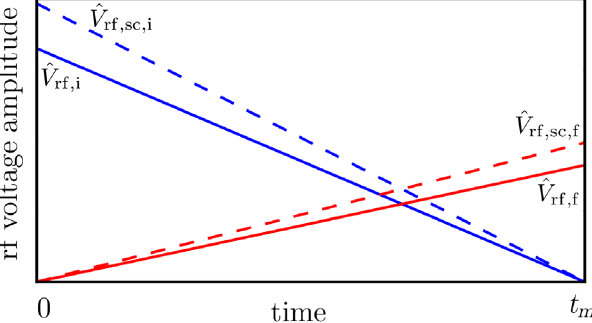
FIG. 4. Schematic of the matched rf voltage amplitude ramps for initial harmonic (blue) and final harmonic (red) with (dashed line) and without (solid line) space charge during bunch merging. ( t represents the merging m